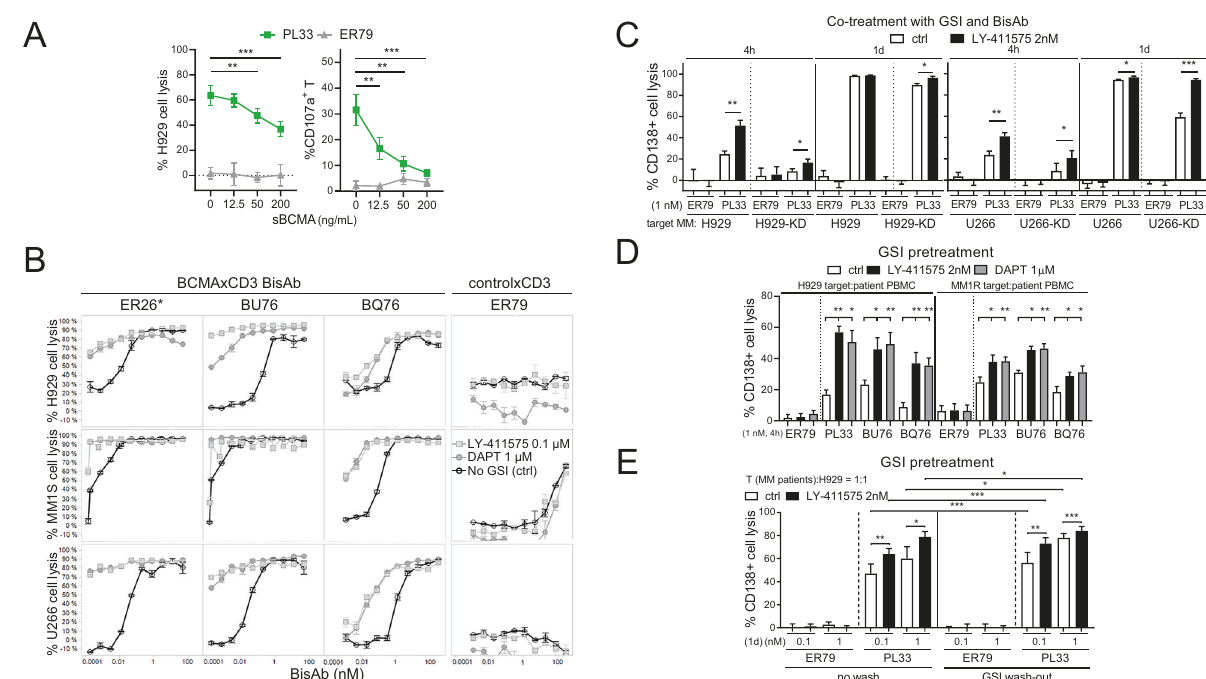
Fig. 2 BCMAxCD3 bispeci fi c antibodies (BisAbs)-induced MM cytolysis was signi fi cantly enhanced by GSI, in the presence of MM patient effector cells. A Serial dilutions of recombinant BCMA protein (sBCMA, 12.5 – 200 ng/mL) were added for 1 day in the co-cultures of patient T cells ( n = 5) with H929 target MM cells (E:T = 1:1) in the presence of PL33 (BCMAxCD3, green square) vs. ER79 (non-targeting controlxCD3, gray triangle) BisAbs. Quantitative FC-based redirected T-cell cytotoxicity (RTCC) assays were used to determine % lysis of CD138 + target MM cells. Shown are summary data of % lysis of H929 cells (left) and CD107a degranulation on patient T cells (right). B Quantitative bioluminescence (BLI)-based RTCC assays were used to determine % lysis of 3 indicated MM target cells by T cells ( n = 3) (E:T = 3:1) in the presence of 3 other BCMAxCD3 (ER26, BU76 or BQ76) clones vs. ER79, with or without 0.1 μ M LY-411575 (gray square) or 1 μ M DAPT (gray circle). No GSI control media (ctrl, black) was included. *ER26 has the same anti-BCMA Fab as PL33 used in all other fi gures. C – E Quantitative FC-based RTCC assays were used to determine % lysis of CD138 + target MM cells. C PL33 or ER79 (1 nM) were added for 4 h or 1 day in the co- culture of patient T cells ( n = 5) with indicated paired MM target cells (control vector-transfected and BCMA-KD) (E:T = 3:1), in the presence of 2 nM LY-411575 or ctrl media. D H929 and MM1R target cells were pretreated with LY-411575 (2 nM) or DAPT (1 μ M) followed by 4 h-co- incubation with MM patient PBMCs ( n = 8) (E:T = 10:1) in the presence of indicated BisAbs (1 nM). ( E ) H929 target cells were pretreated with LY-411575 (2 nM) for 1 day. LY-411575 was then washed out (wash-out) or not (no wash) prior to 1 day-co-culture with MM patient T cells ( n = 5) (E:T = 1:1) in the presence of PL33 vs. ER79. Multiple independent experiments using effector cells from MM patients ( A n = 5; C n = 5; D n = 8; E n = 5) or normal donors ( B , n = 3) were done with each treatment condition in triplicate. Data are presented as means ± SDs (error bars). * P < 0.05; ** P < 0.01; *** P < 0.001; **** P < 0.0001; ns, not signi fi 10) and DAPT (MM4-7, n = 4) upregulated mBCMA levels on patient MM cells by ~3.9 – 8.4- and 2.6-3.7-fold, respectively (Fig. 3C, lower panel). Furthermore, concentrations of sBCMA nega- tively associated with mBCMA levels, being undetectable in ~75% culture supernatants treated with GSI (Fig. 3D). No mBCMA was detected on CD3 + T cells from another 9 MM patients with baseline mBCMA molecules on the paired CD138 + cells ranging from 414 to 5011 (Fig. 3E, left panel). Following GSI treatments for 1 day, mBCMA levels on CD138 + cells were increased from 3034 ± 1694 to 18190 ± 12085 for LY-411575 ( P < 0.002) and to 10114 ± 2437 for DAPT ( P < 0.0001). GSIs speci fi cally upregulated mBCMA expression on CD138 + cells by as much as 22-fold, without impacting paired patient T cells. Meanwhile, sBCMA levels in matched 1 day-culture supernatants of patient BMMCs were decreased from ~6000 pg/mL (mean: 1597 pg/mL; SD: 1755 pg/mL) to undetectable in 7 out of 9 samples for LY-411575 (mean: 30.81 pg/mL; SD: 46.75 pg/mL) or DAPT treatment (20.96 pg/mL; SD: 33.58 pg/mL) ( P < 0.02, Fig. 3E, right panel). Thus, GSIs effectively blocked BCMA shedding from patient MM cells. Following 1 day-incubation, PL33-induced patient autologous lysis were next shown using BMMCs from 6 RR MM patients with BCMA ABC ranging from 608 to 5048 on CD138 + PCs (Fig. 3F). As